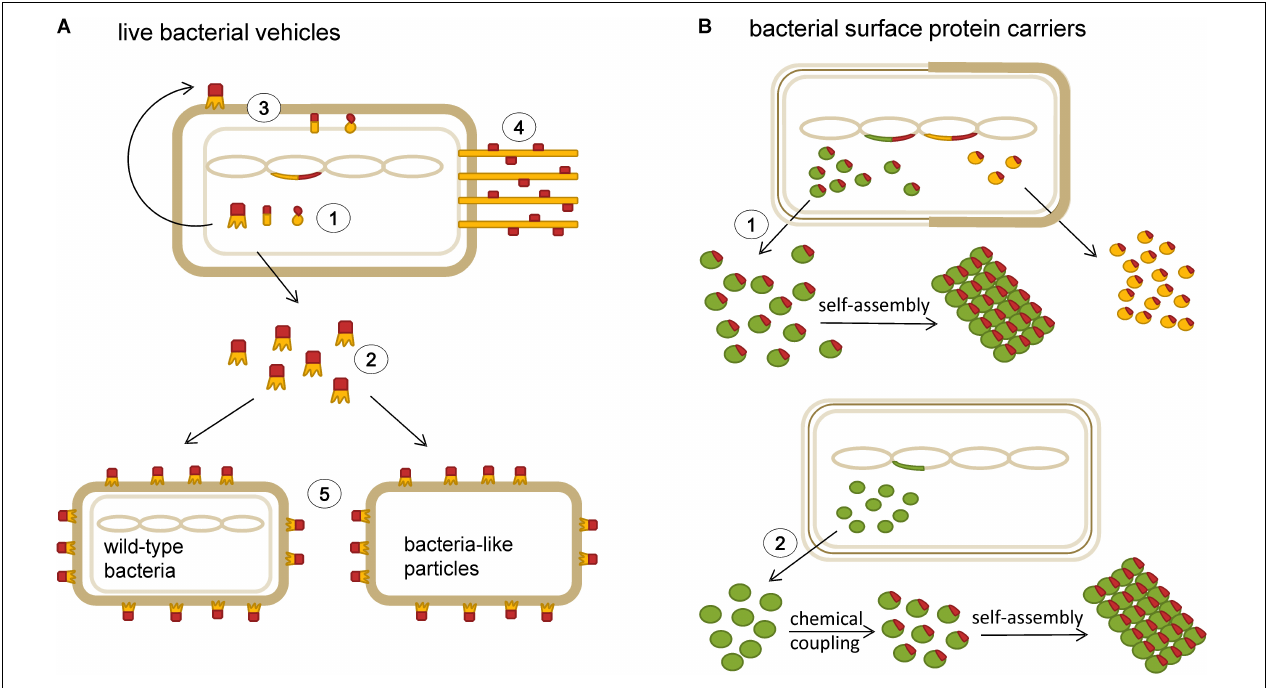
FIGURE 2 | Schematic representation of bacterial delivery vehicles that have been tested for use in allergy immunotherapy. (A) Live bacterial vehicles with various modes of delivery of allergens or allergen-derived peptides (red): intracellular expression (1), secretion (2), membrane- and cell wall display (3), pilus-mediated display (4); heterologous display (5). (B) Bacterial surface protein carriers; S-layer proteins (green) and albumin binding protein (yellow): recombinant expression of carrier proteins with allergen-derived peptides (1), isolation of surface proteins and chemical coupling to allergens or allergen-derived peptides